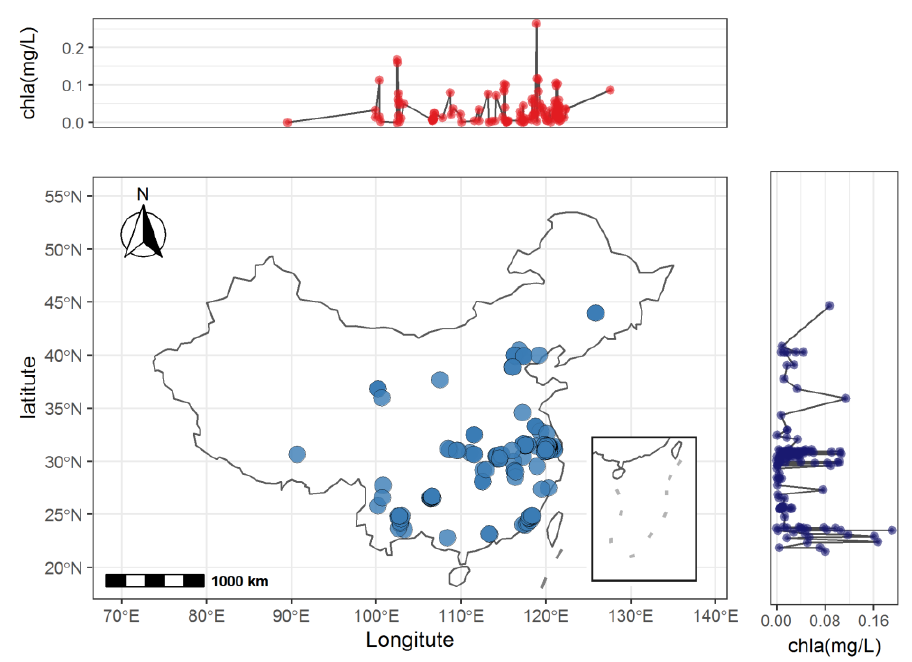
Figure 1. Distribution of lakes with measured chlorophyll a values in China (the top and right graphs represent the distribution of the chlorophyll a concentration content at different latitudes and longitudes, respectively).